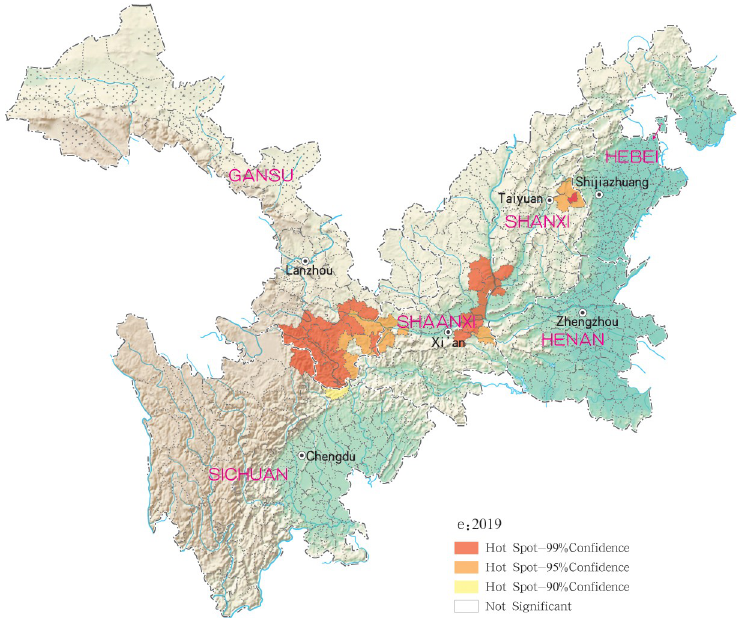
Fig 10. Hotspot analysis of mountain-type zoonotic visceral leishmaniasis incidence in 6 provinces, China in 2019.